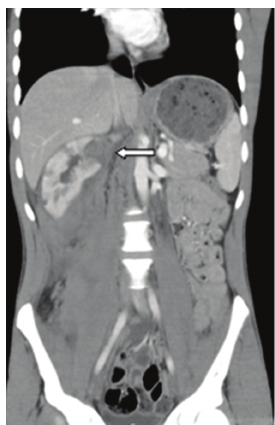
Figure 1: Contrast enhanced computed tomography of the patient where multiple infarcts can be seen in right kidney (arrows).